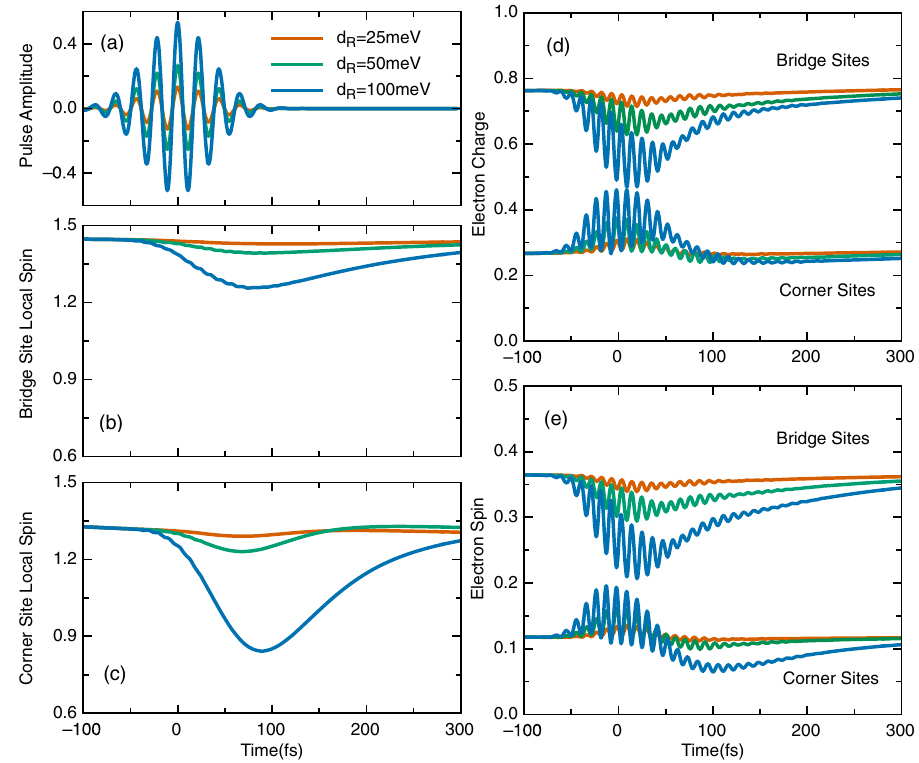
Fig. 2 Nonadiabatic charge and spin dynamics driven by few-cycle electric fi elds. a The electric fi elds used in the simulations to obtain ultrafast time modulation of the intersite electronic hopping amplitudes. b , c Bridge and corner site local spin dynamics, S z ( t ). d , e Itinerant electron charge and spin dynamics at the bridge and corner